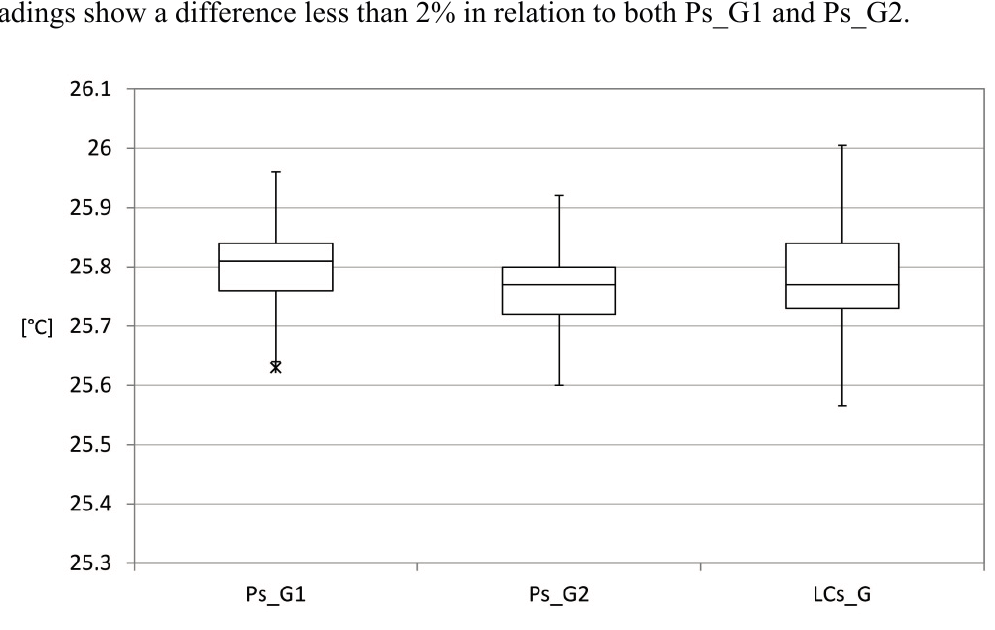
Figure 7. Radiant temperature: indexes of position and variability of the data—Complete